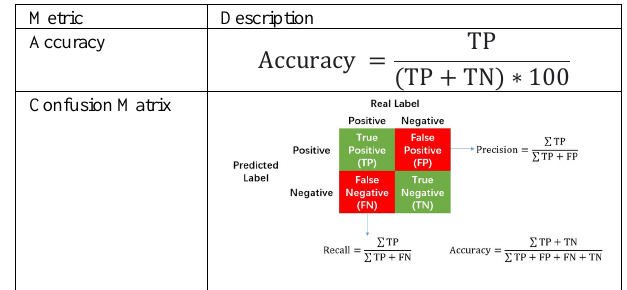
Table 2. Description of